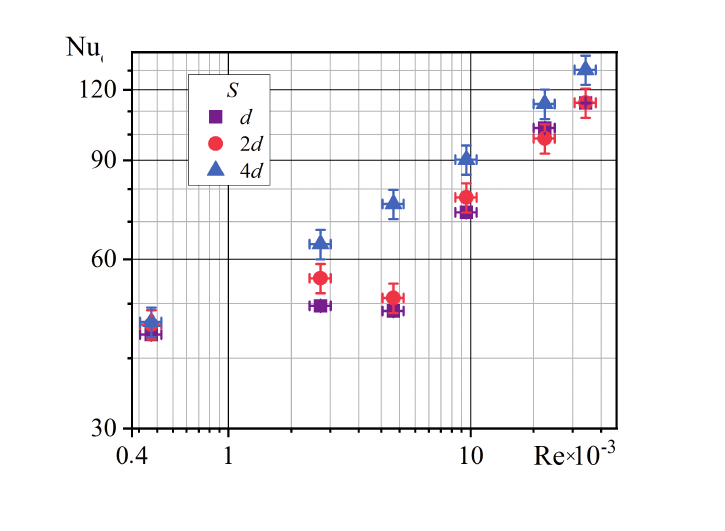
Figure 15. Dependence of the surface-averaged Nusselt number for the second cylinder from the